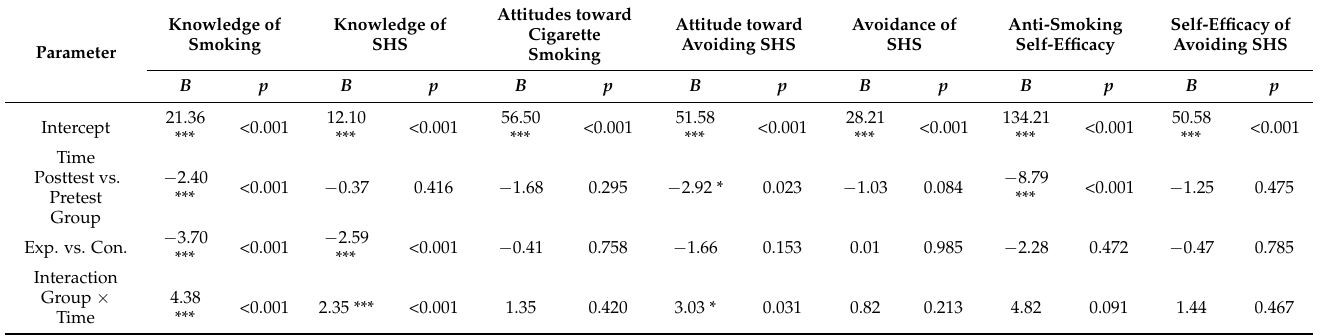
Table 4. Effects of smoking prevention programs on knowledge, attitude, and self-efficacy ( n =